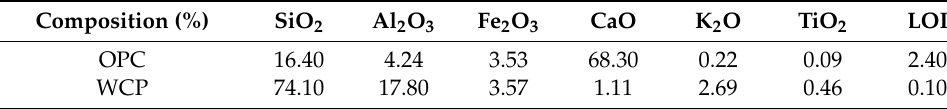
Table 1. Compositions of ceramic waste powder and